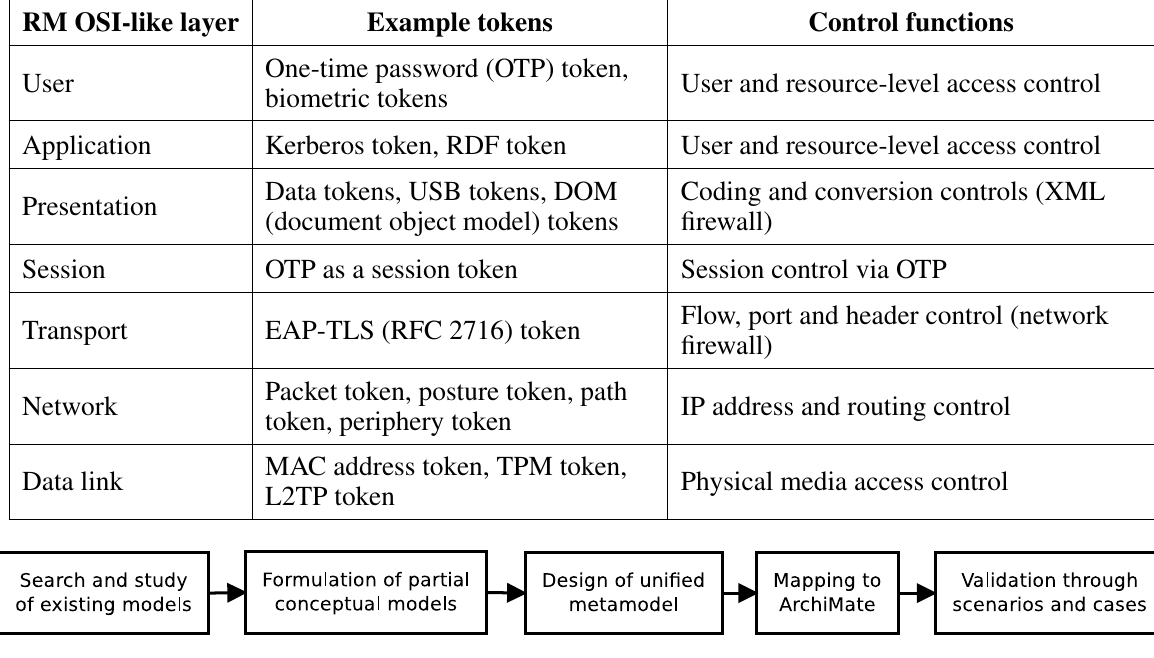
Figure 3. Outline of the study